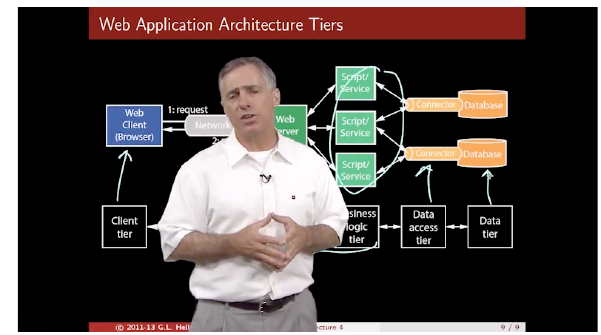
Figure 8: Web Application